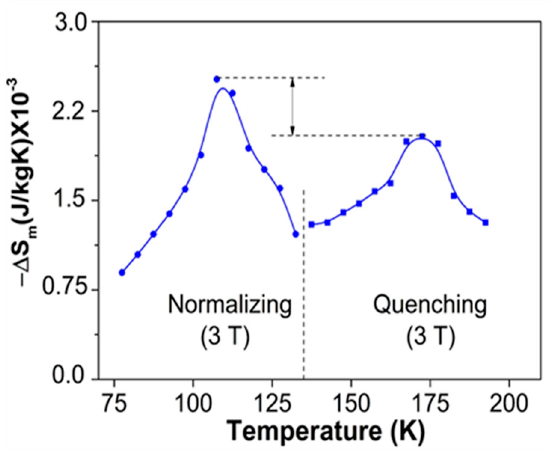
Figure 7. − ∆ S m obtained at 3 Tesla as a function of temperature in samples subjected to quenching and normalizing.